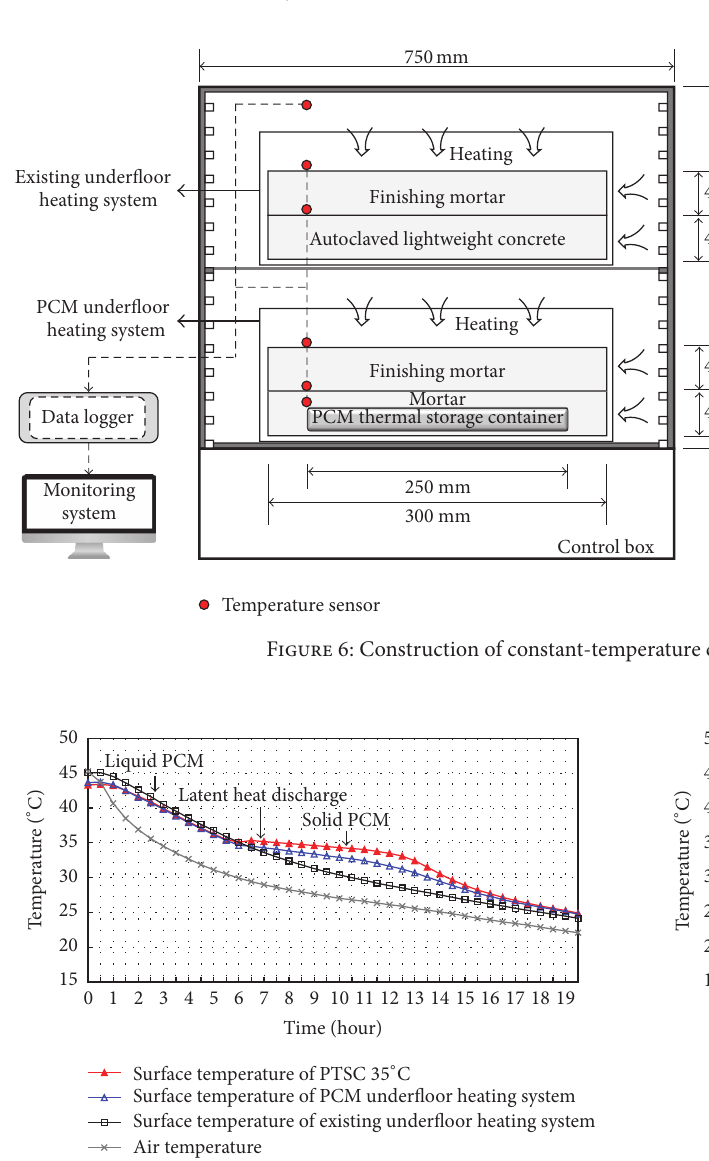
Figure 7: Surface temperatures of existing underfloor heating system and PUFHS with PTSC 35 ∘ C.